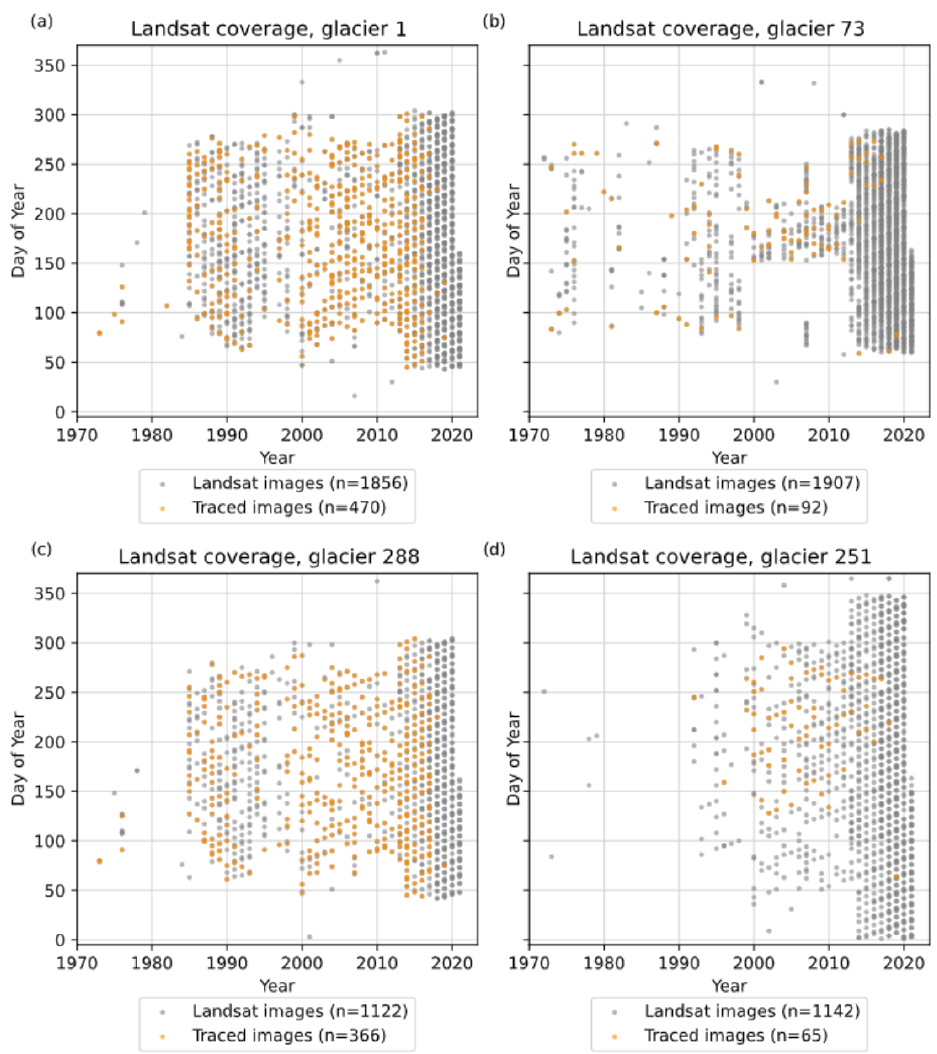
Figure 11. Examples of Landsat image availability (gray) versus termini traced (orange) for (a) Kangilliup Sermia (Rink Isbræ; 1), a relatively well-traced glacier, (b) Qeqertaarsuusarsuup Sermia (Tracy Gletscher; 73), a glacier representative of the average number of total traces for this data set, (c) Sermeq Silarleq (288), the glacier with the highest percentage of available Landsat images that have been traced in this data set, and (d) an unnamed glacier (251), representative of the average percentage of available Landsat images that have been traced in this data